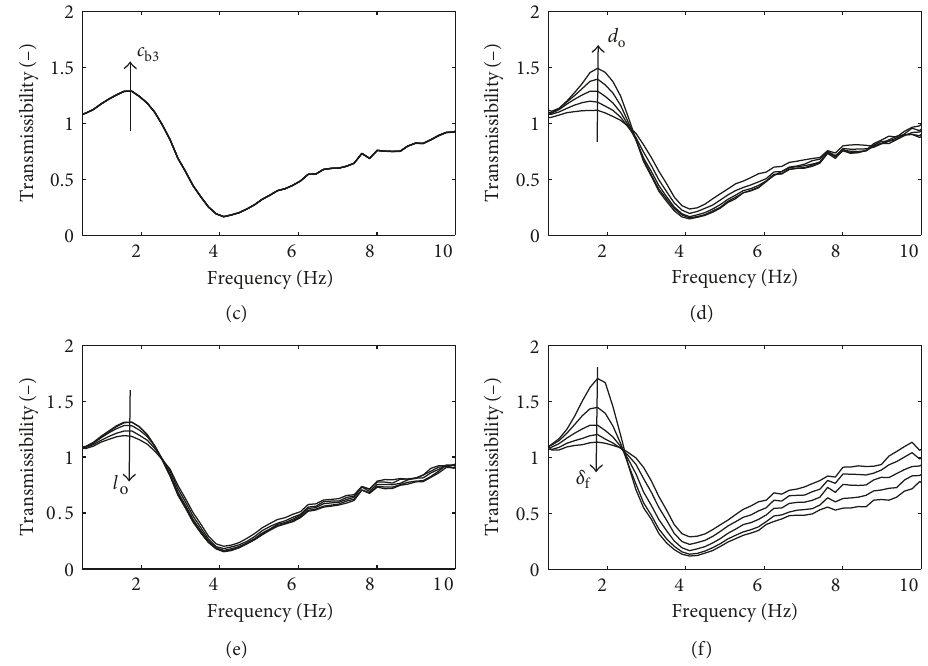
Figure 8: Transmissibility functions of the horizontal seat suspension at different input factors: wire diameter of the helical springs d linear stiffness coefficient of the end-stop buffers c absorber d (d), orifice length of the shock absorber l o